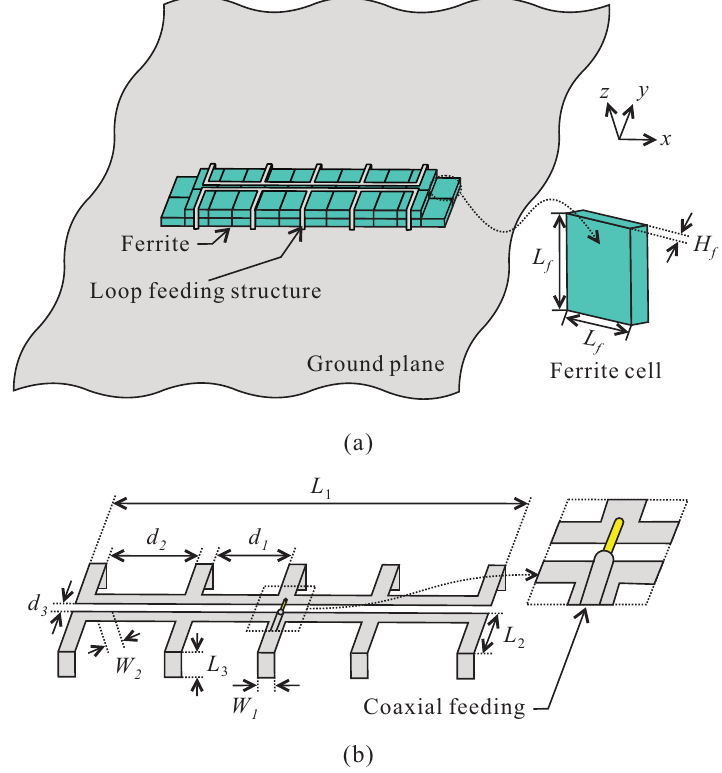
Figure 1. Geometry of the proposed antenna: ( a ) 3-D view and ( b ) feeding structure.